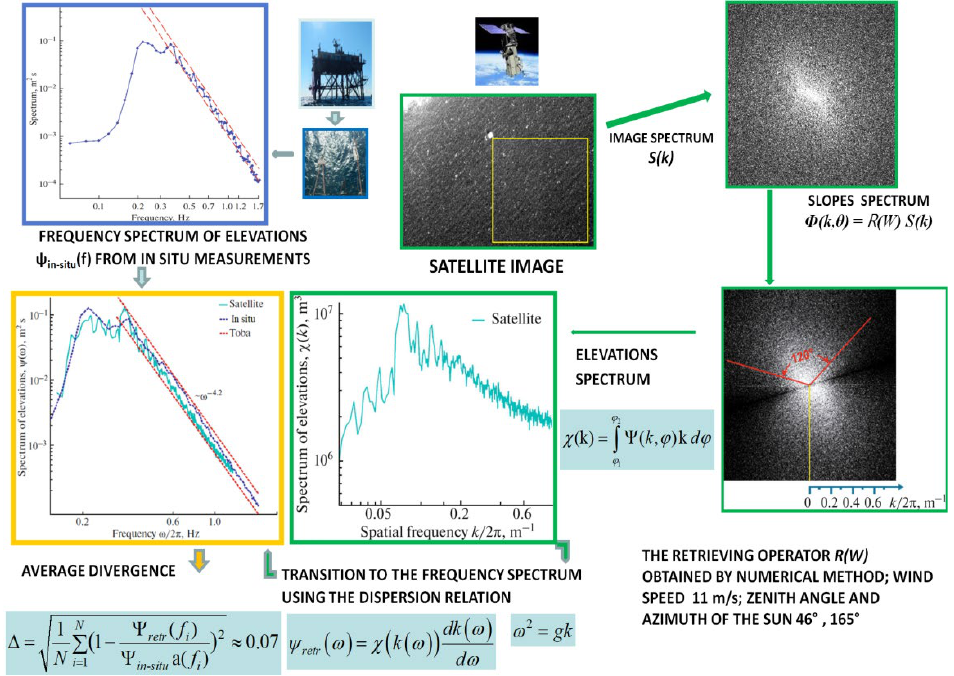
Figure 1. Illustration for the validation method of remote methods for measuring wave spectra by recalculation and comparison with the in situ data where 2 f ω π= ⋅ is the circular frequency.